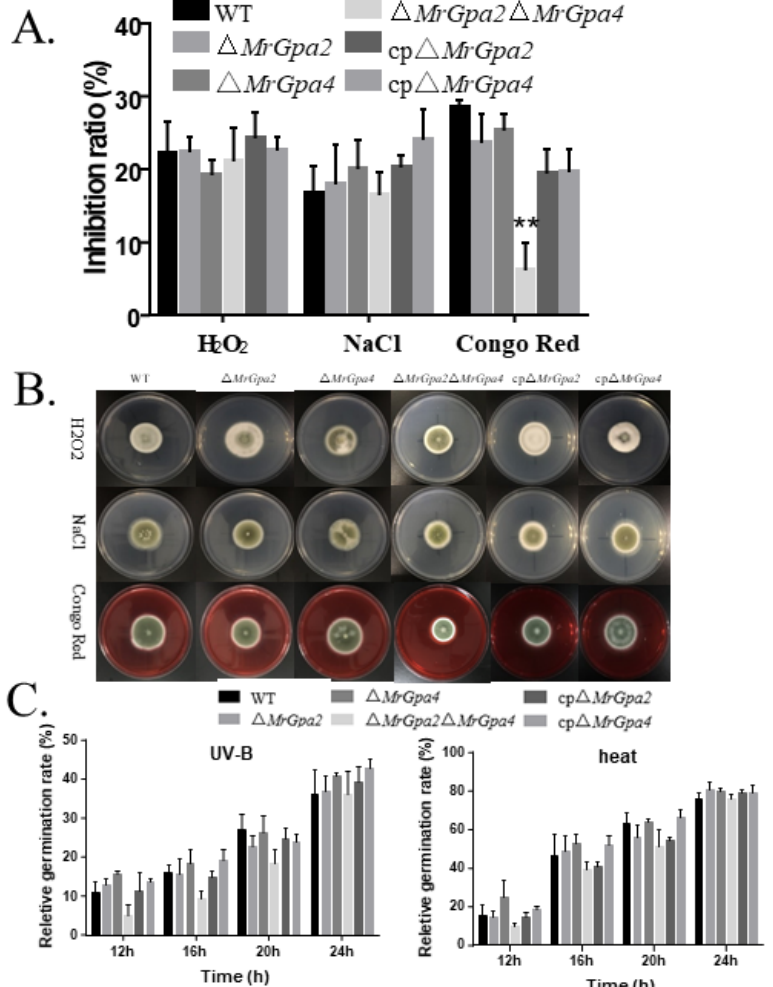
Figure 6. MrGpa2 and MrGpa4 affect cell wall integrity. ( A ) Inhibition ratio of six fungal strains on PDA medium containing NaCl (0.5 M), H2O2 (10 mM), or Congo red (2 mg/mL). ( B ) Colony phenotype of WT and ∆ MrGpa2 ∆ MrGpa4 strains. ( C ) Conidial relative germination of six strains on PDA medium 12, 16, 20, and 24 h after exposure to UV-B irradiation stress or heat stress at 42 °C. ** p < 0.01.